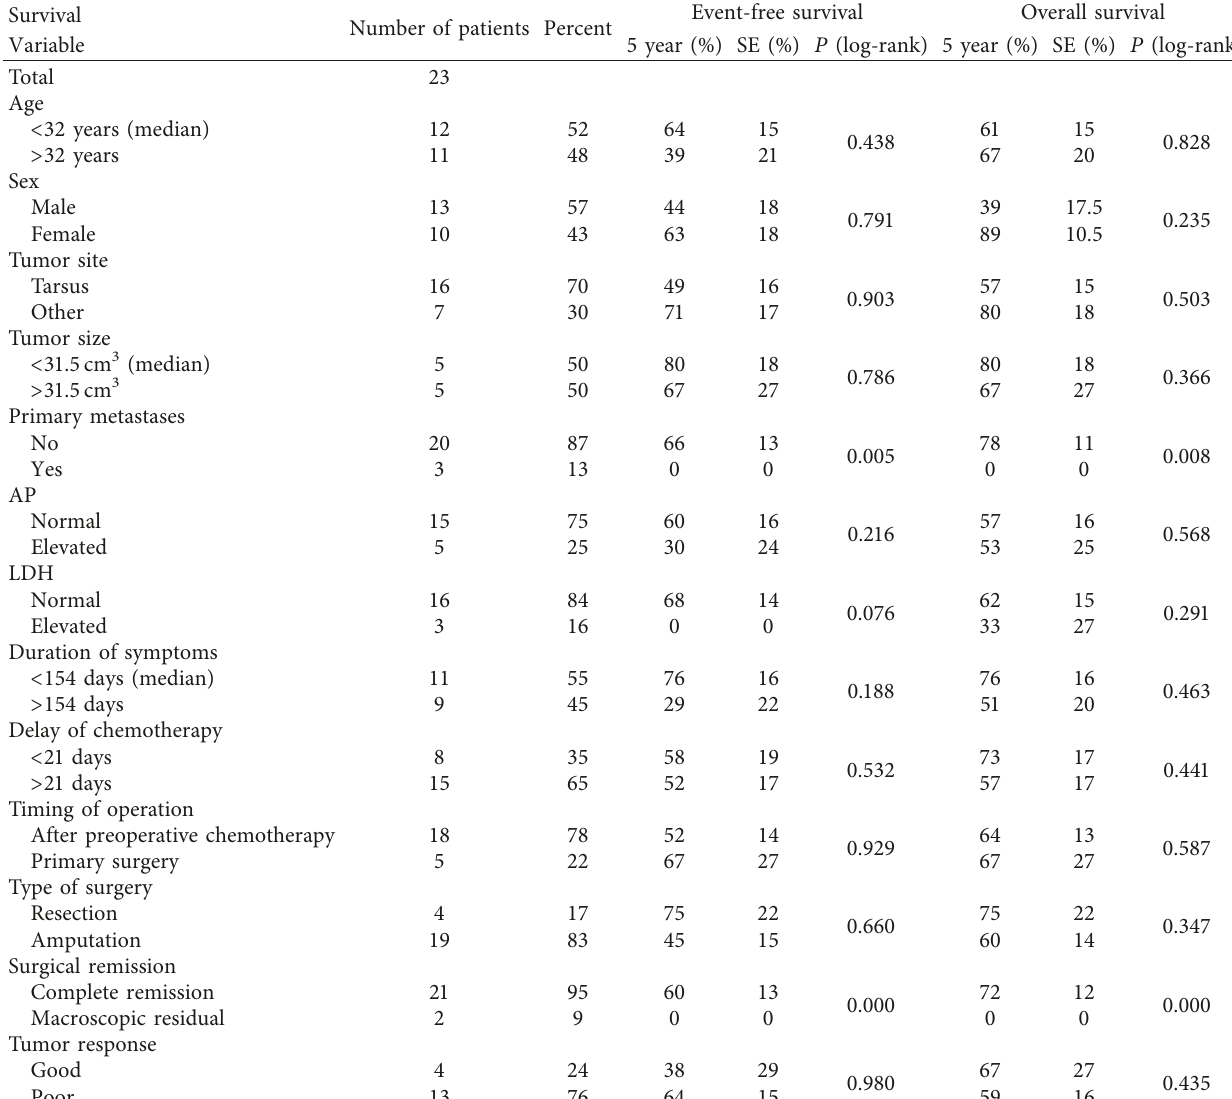
Table 6: Univariate analysis of overall and event-free